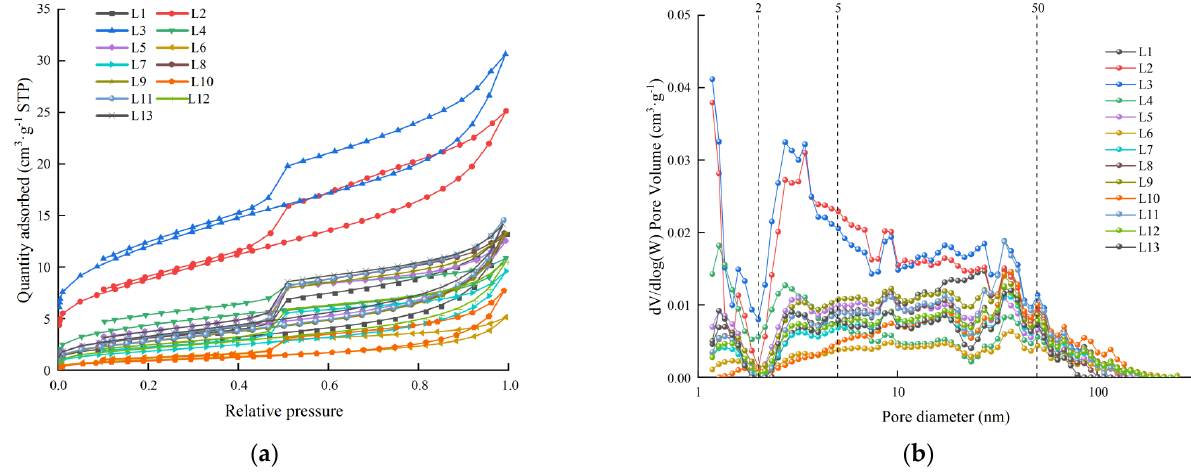
Figure 5. ( a ) The nitrogen adsorption–desorption curves of samples; ( b ) Pore size distribution of samples.